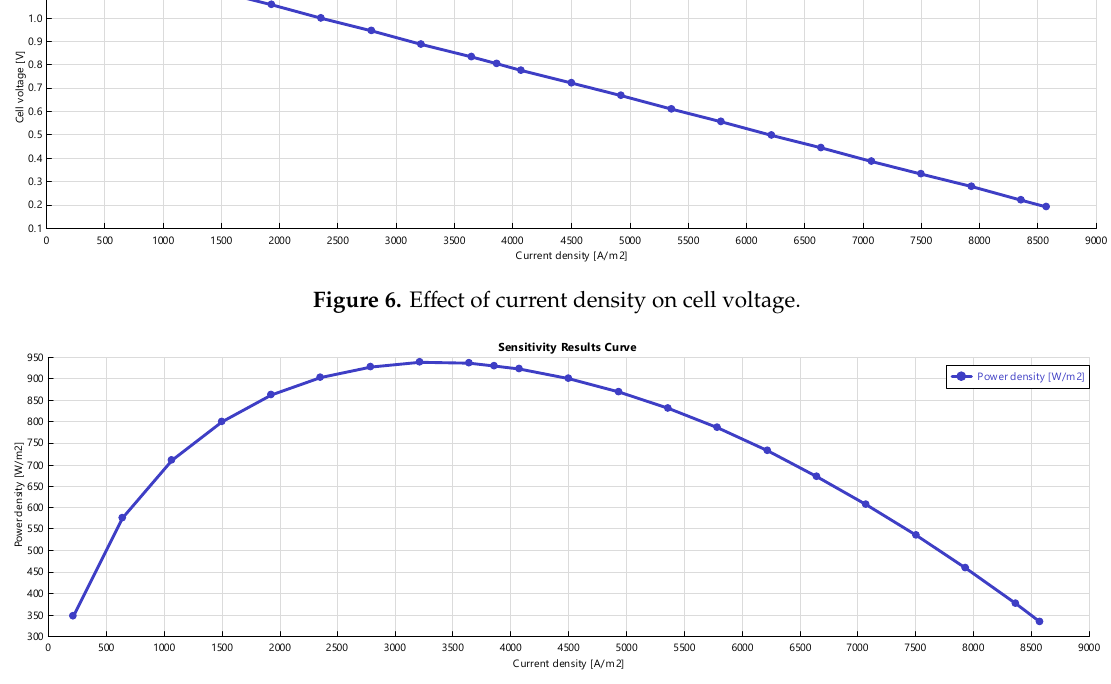
Figure 7. E ff ect of current density on power Figure 7. Effect of current density on power density. Figure 7. Effect of current density on power density. Figure 7. Effect of current density on power density.